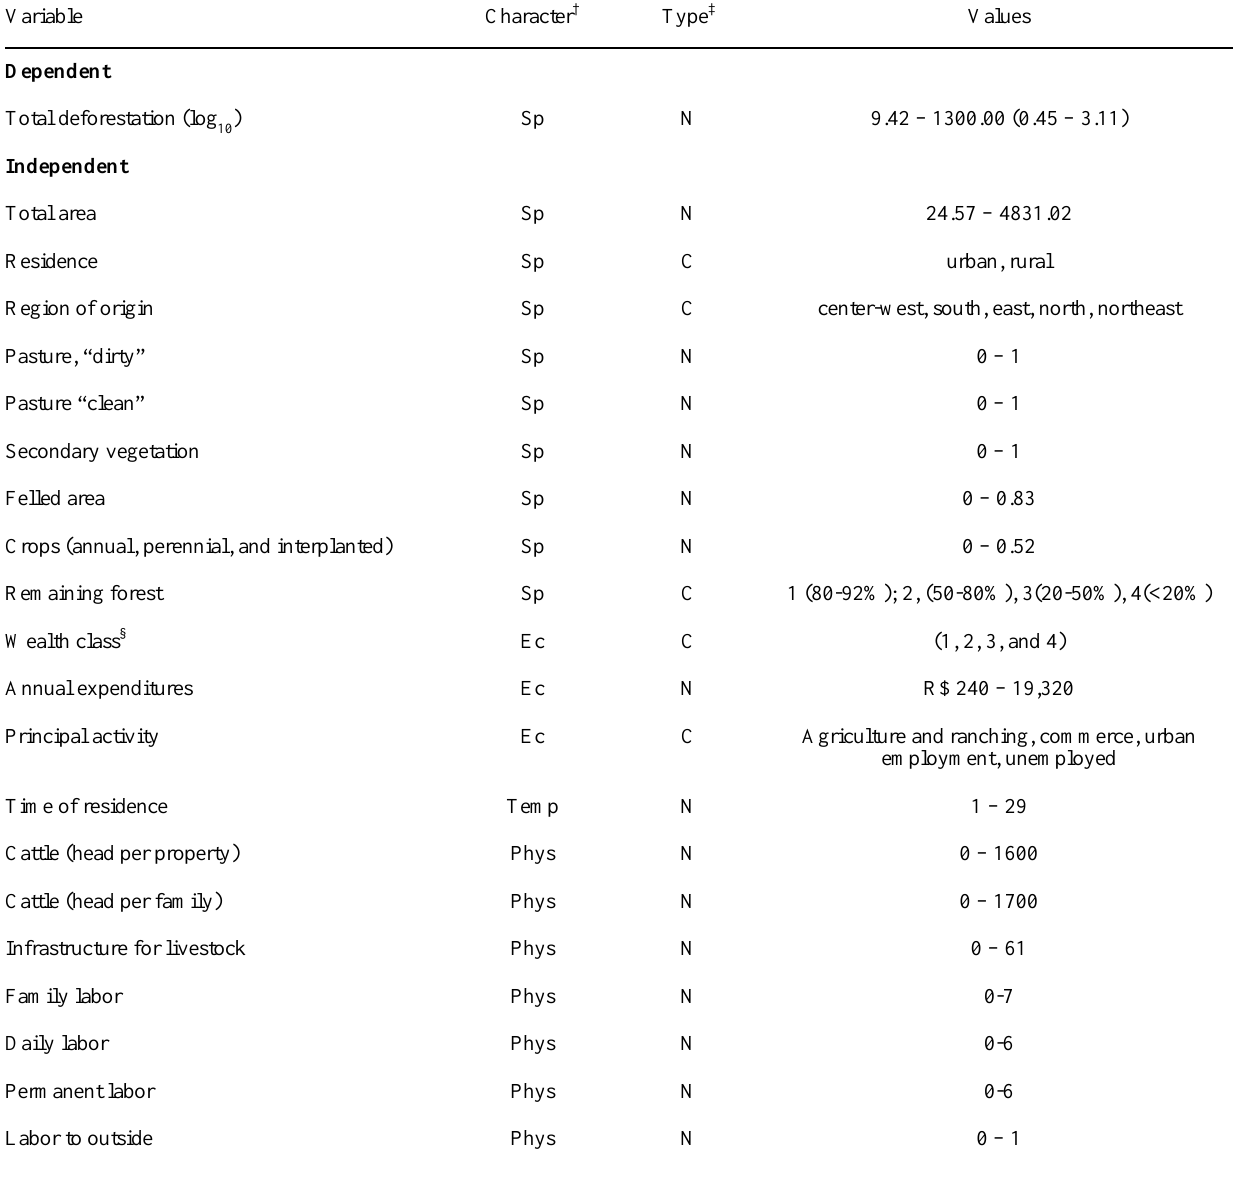
Table 1. Description of the variables used in the regression–tree